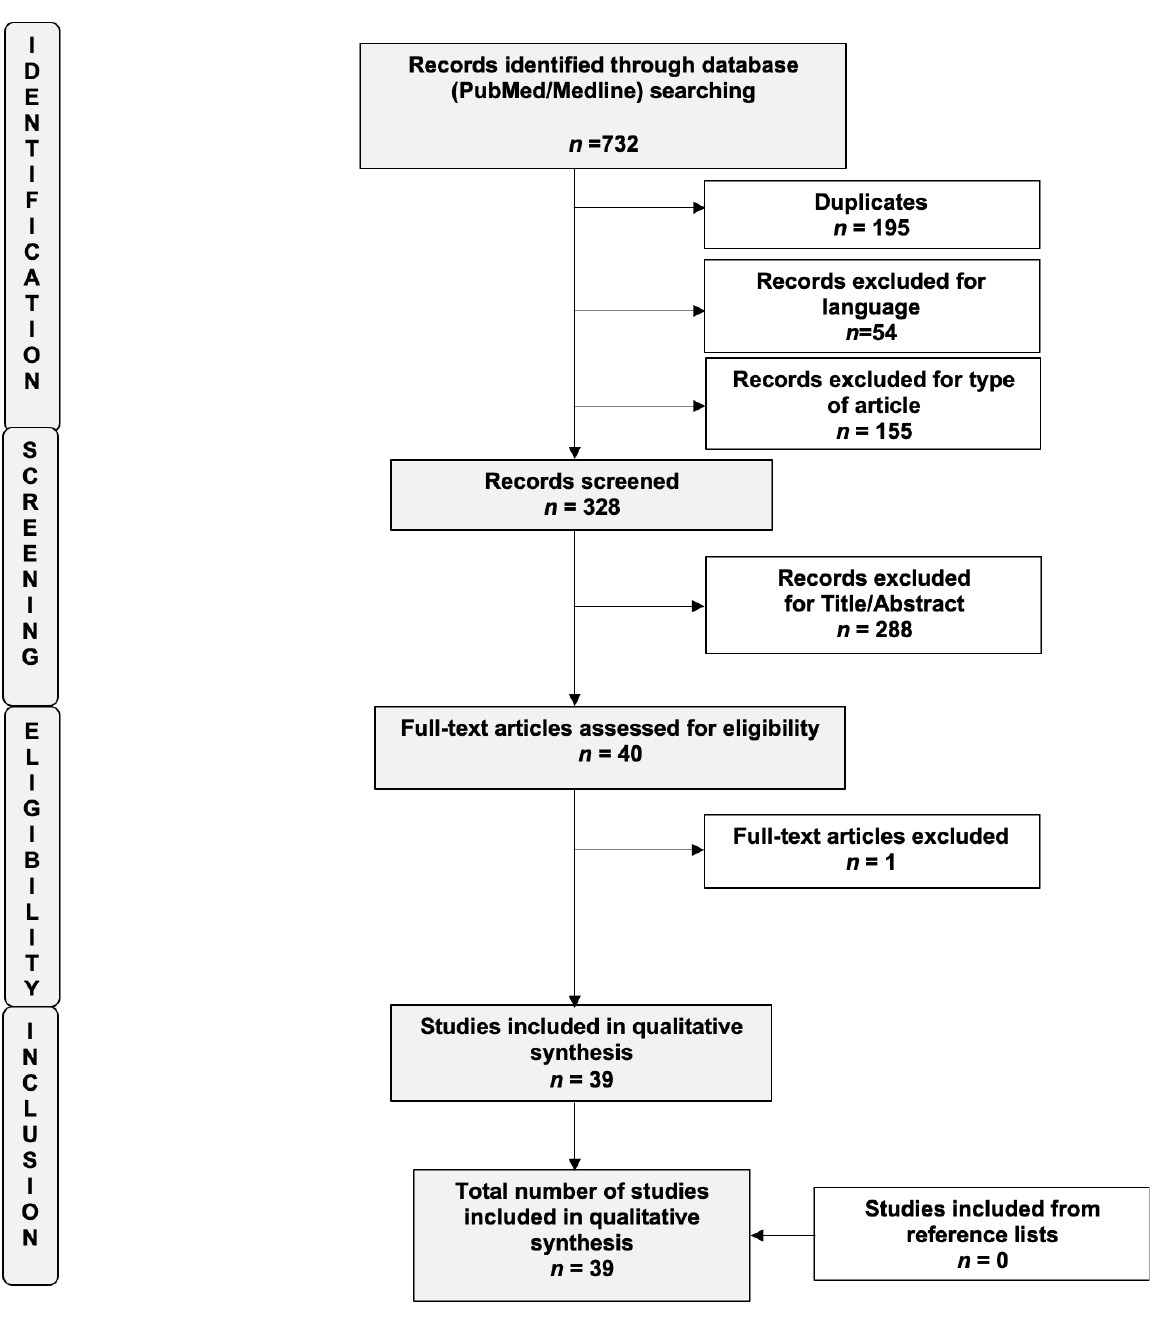
Figure 1. Flow diagram of the search strategy, screening, eligibility, and inclusion criteria (PRISMA template).